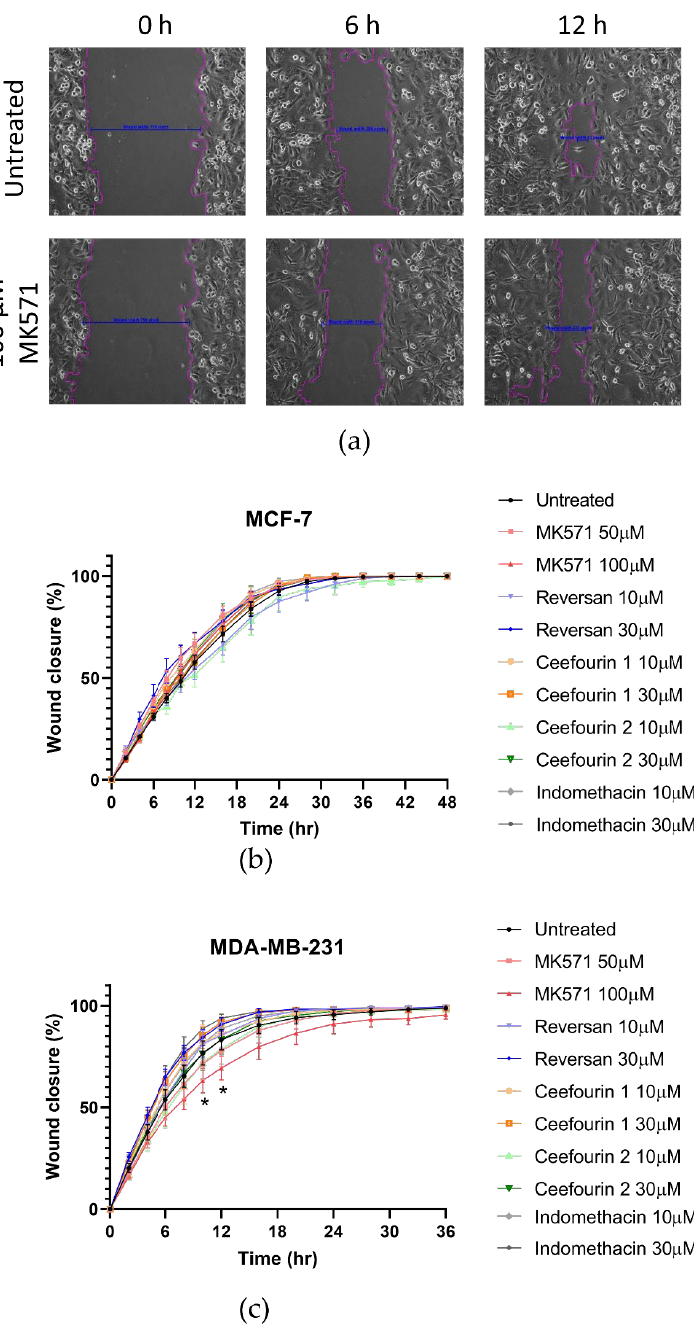
Figure 4. MK571 decreases the rate of migration by MDA-MB-231 cells. Cells were seeded in 24-well plates to reach 100% confluency the day of the assay. A scratch across the monolayer of the cells was carefully made, and the medium was replaced with fresh prewarmed culture medium. Cells were treated with the inhibitors as described above. Three image positions were selected from each well, and images were taken at 1-h intervals using the Cell-IQ. Representative images of MDA-MB-231 scratch assay ( a ). Pink lines represent the scratch edges as defined by the Cell IQ software, and the blue lines are the distance measurement between the edges. Average results for MCF-7 ( b ) and MDA-MB-231 ( c ) cell migration in the presence of inhibitors. Data are mean ± sem, n ≥ 6. Data were analyzed using a two-way ANOVA with a Dunnett’s post hoc test. * p < 0.05 significantly lower than the untreated